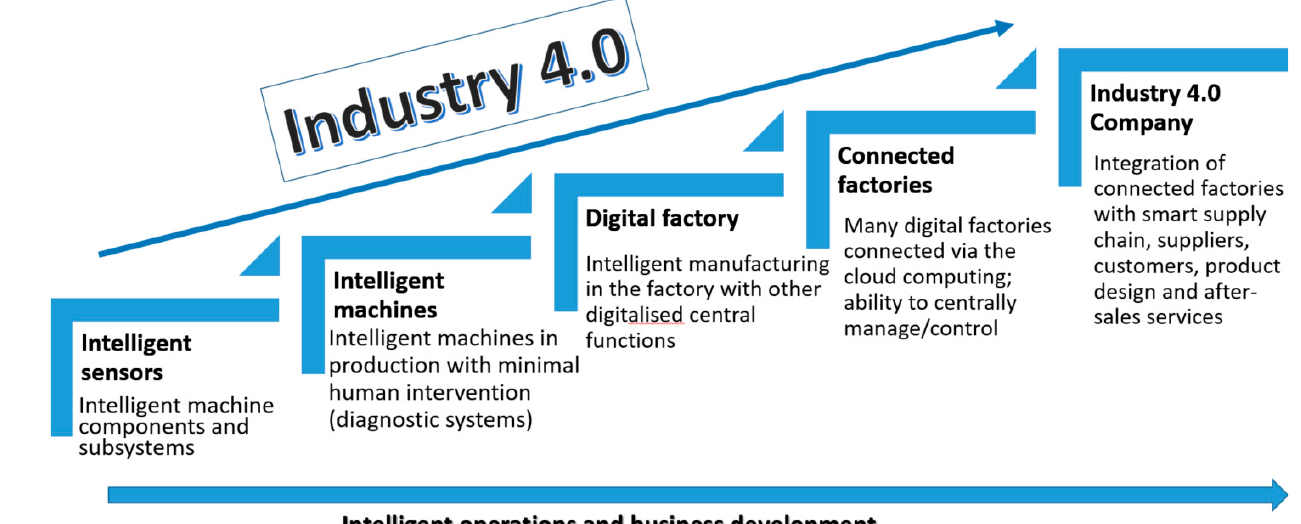
Figure 4. Development directions in Industry 4.0—what are businesses working towards? Source: own contribution based on [52].